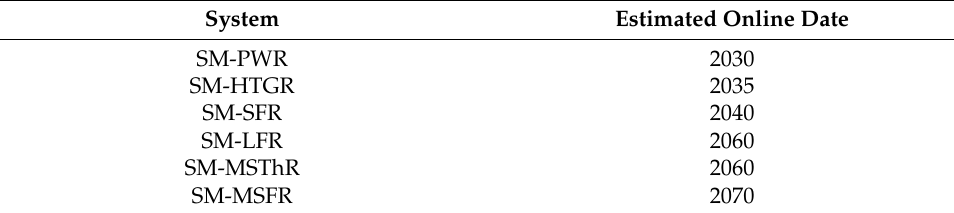
Figure 6. Time and Effort to License from GFAs. Table 1. On-line dates for the various systems as estimated by